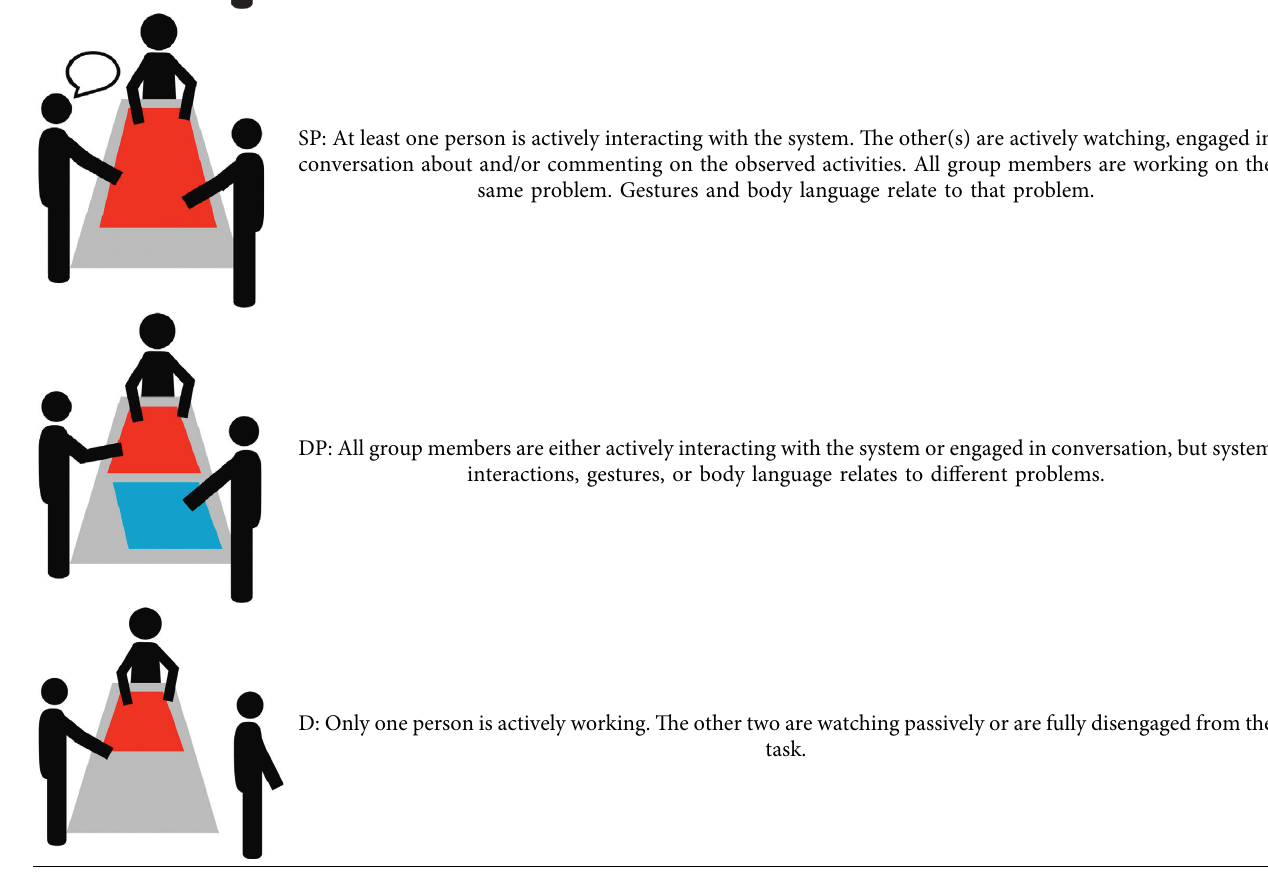
Disc: Active discussion about the task or proposed strategies. Only minor system interaction (e.g., pointing to items or marker use).